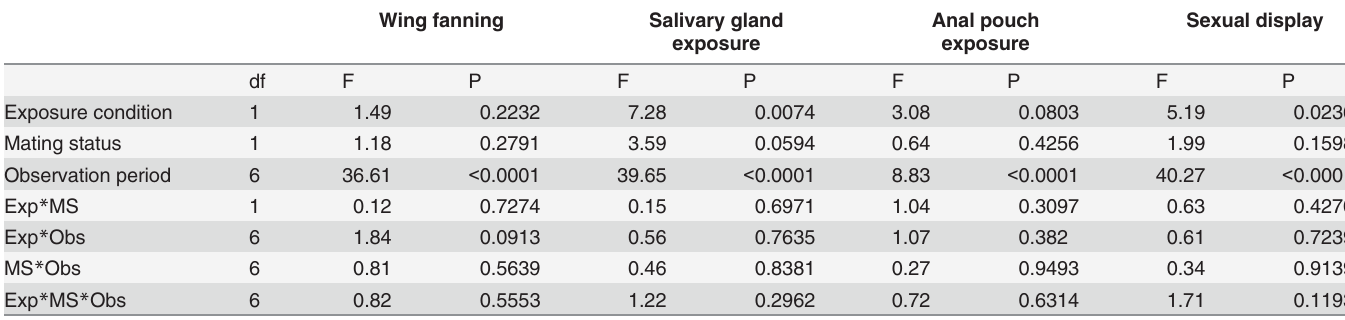
Table 1. General Linear Model analysis for experiment 2.